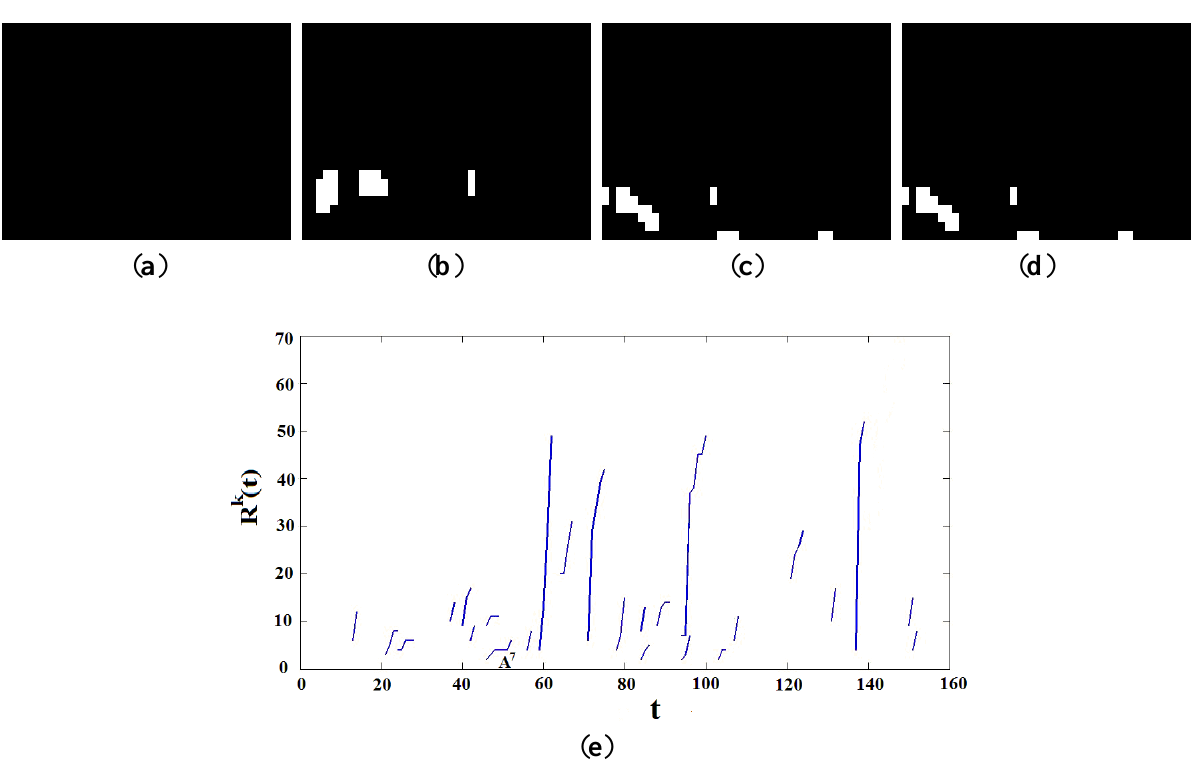
Figure 10. Behavior of k = 1… K of a video sequences without